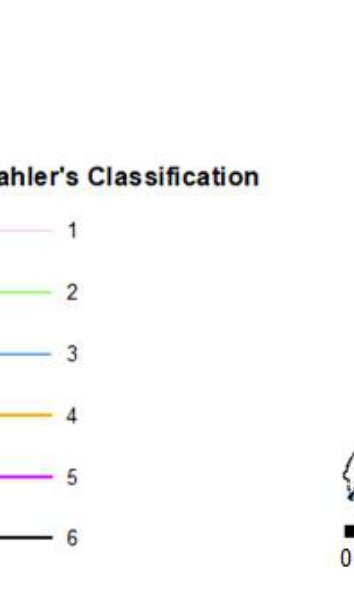
Table 3. Peak flow rate. Figure 6. Strahler classification (Source: Authors by ESRI ArcGIS, 2020).